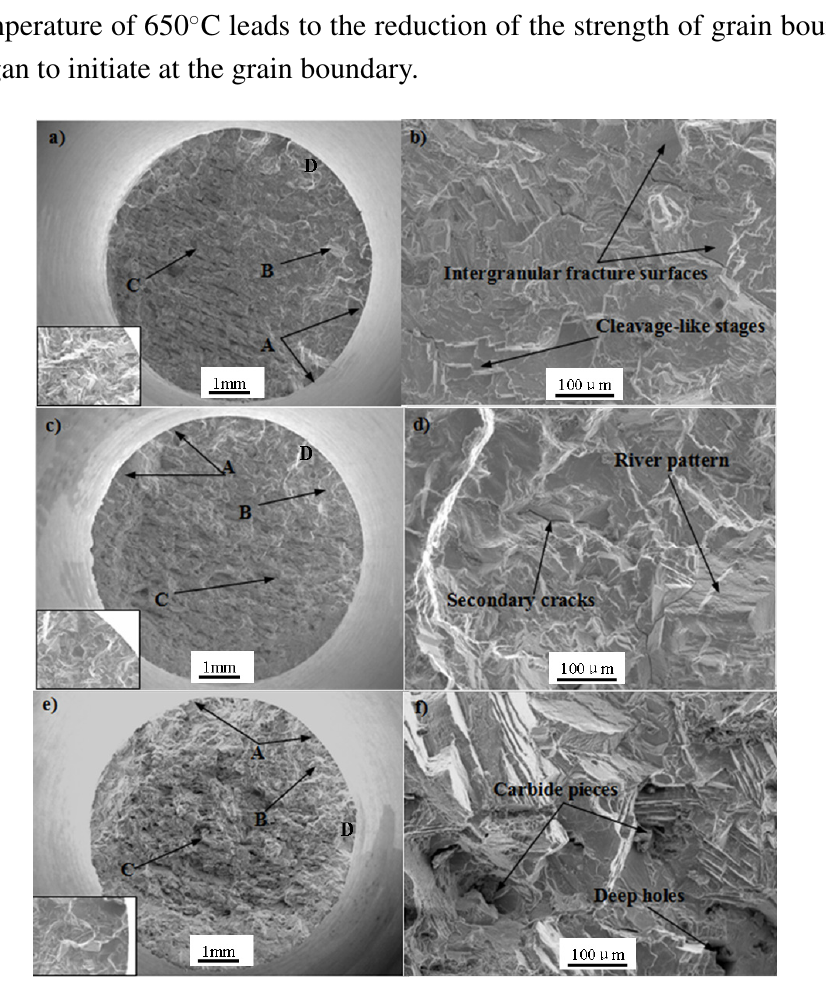
/2 = 0.4%; ( c , d ) ∆ ε /2 = 0.6%; t t